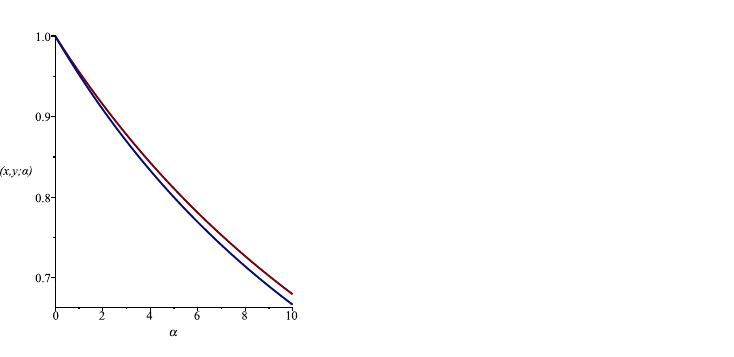
Figure 1. Functions M 0 ( α ) (below) and M ( x , y ; α ) for α in the interval ( 0,10 ) , when λ = 1, k 1 = 0, k 2 = 1 and y − x = 0.5.